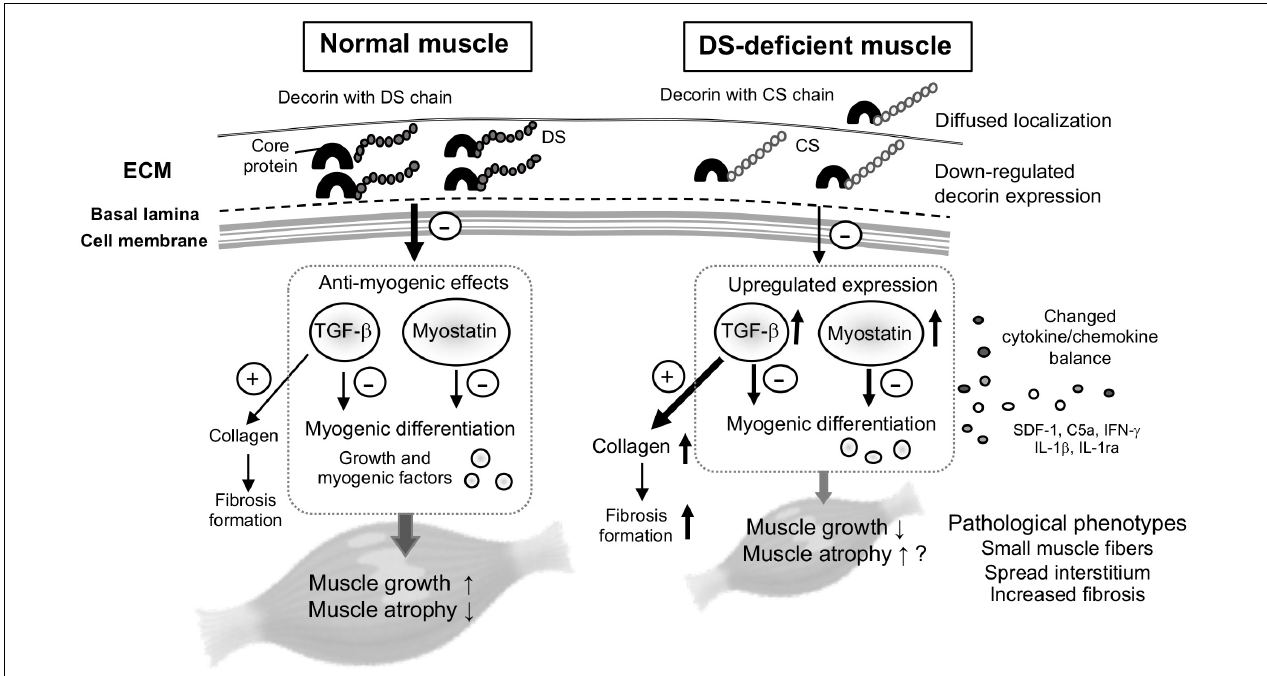
FIGURE 4 | Schematic for the proposed hypothesis of this study. Decorin is one of the most abundant proteoglycans in the skeletal muscle, mainly associated with ECM surrounding bundles of myofibers. In normal muscle, decorin acts as a myokine through the pathway: inhibition of transforming growth factor (TGF)- β , and down-regulation of myostatin expression, by competitively binding to TGF- β or myostatin . The inhibitory effects on TGF- β or myostatin (arrow with minus mark) might be reduced in DS-deficient muscle, because down-regulation of decorin core protein as well as its modification by CS instead of DS lead to diffused localization and induced up-regulated expression of myostatin and TGF- β , with the resulting collagen production leading to fibrosis. Decorin with CS also leaded to changes in the cytokine/chemokine environment, and might result in delayed muscle growth and pathological phenotypes, but had no effect on expression levels of myogenic factors.